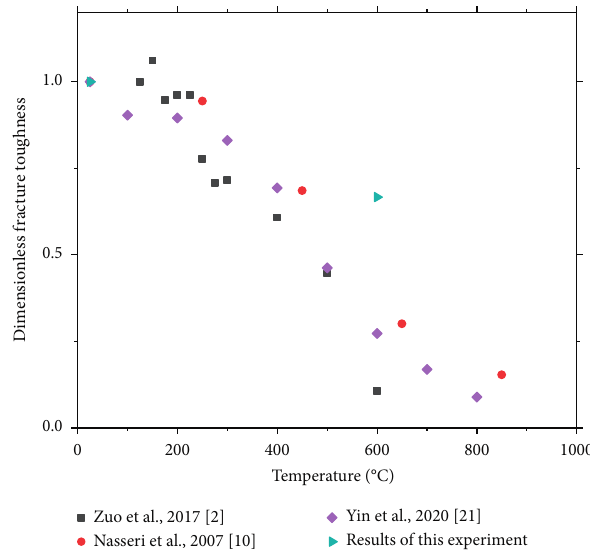
Figure 1: Relationship between fracture toughness and